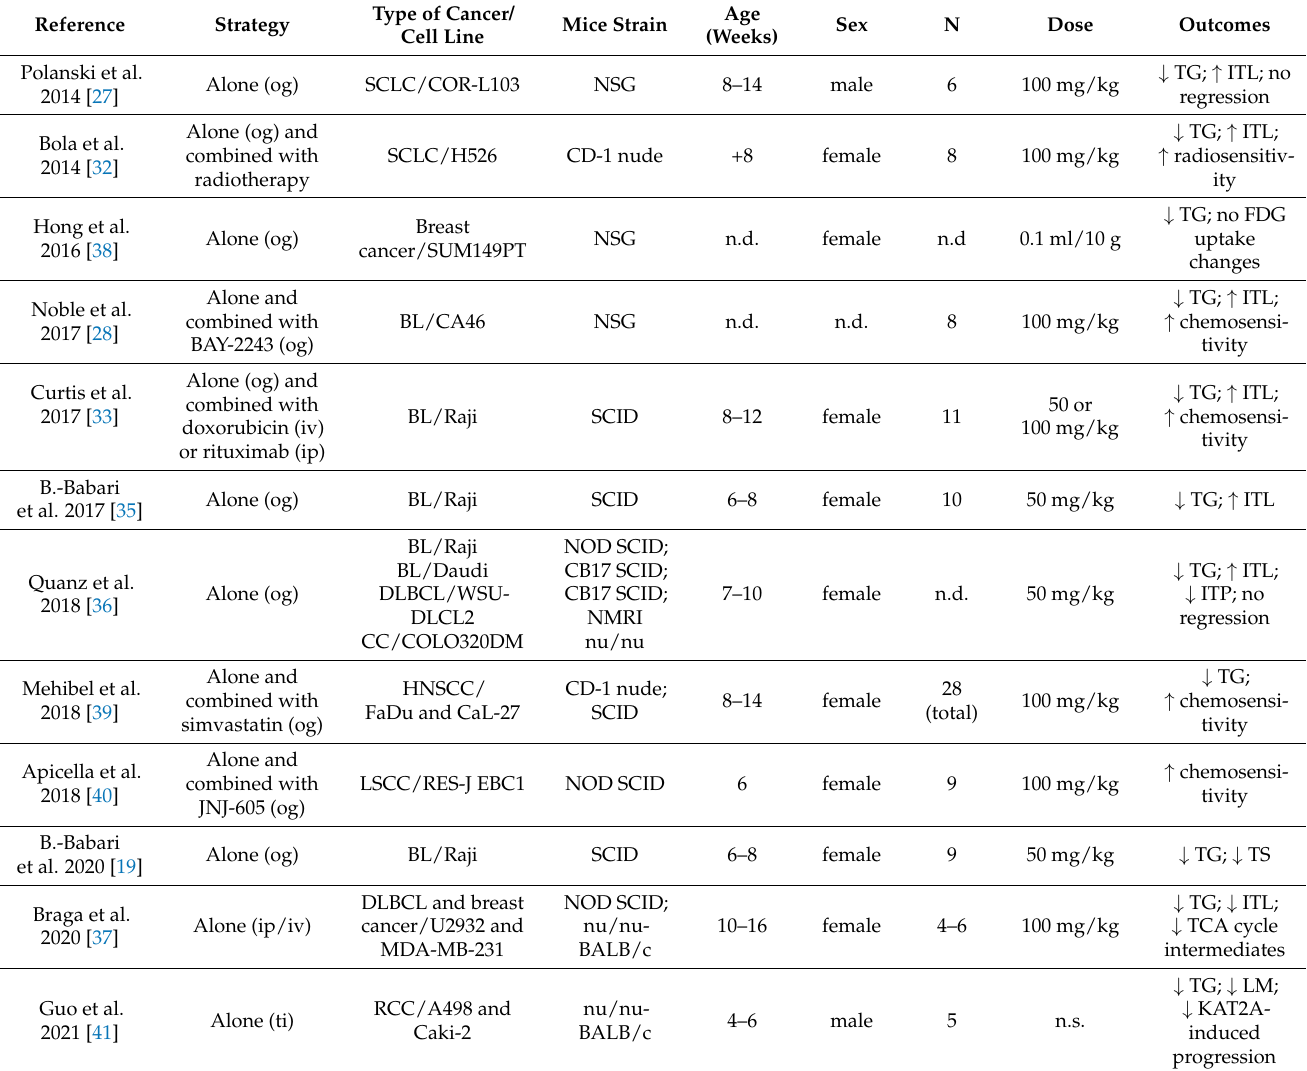
Table 2. Detailed information on eligible